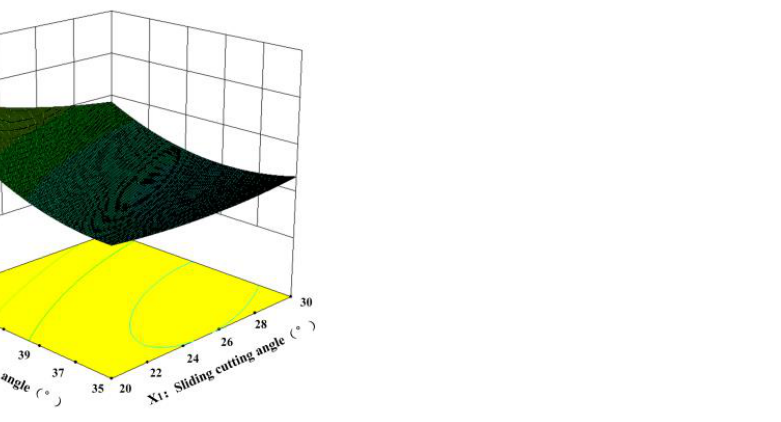
Figure 11. Effects of the sliding – cutting angle and the oblique angle on maximum equivalent stress of the upper cutting blade.